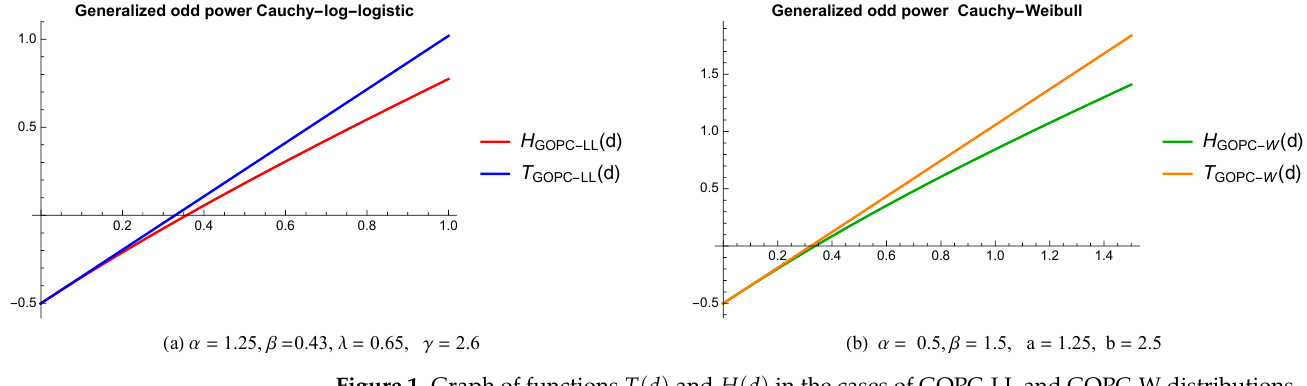
Figure 1. Graph of functions T ( d ) and H ( d ) in the cases of GOPC-LL and GOPC-W distributions. The cumulative distribution function of log-logistic distribution is given by where t > 0, λ > 0 and γ >